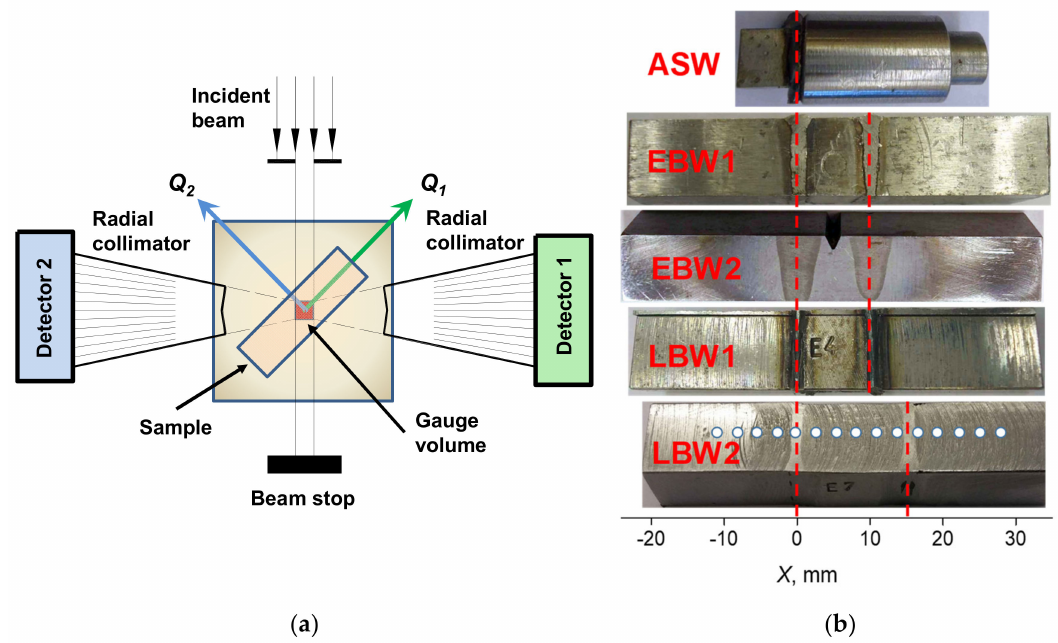
Figure 2. ( a ) Scheme of the experiment for residual stress investigation in a bulk object. Incident and scattered (at the scattering angles 2 θ = ± 90 ◦ ) neutron beams are restricted by diaphragm and radial collimators shaping a small gauge volume within the specimen [18]. Measurement of neutron di ff raction spectra by ± 90 ◦ -detectors allows simultaneous determination of the lattice strains in two mutually orthogonal directions. ( b ) The investigated Charpy specimens reconstituted by various welding techniques. Weld seams positions are indicated by vertical dash lines. For LBW2, specimen scan points are shown. The similar scans were performed for all studied